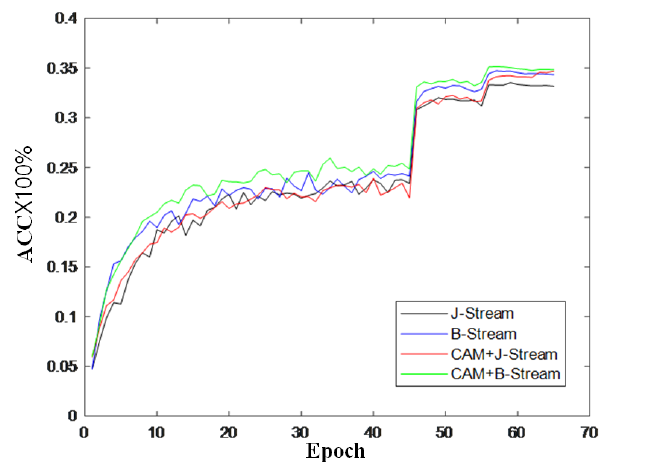
Figure 10. Accuracy change curve on CS index of NTU-RGB + D.